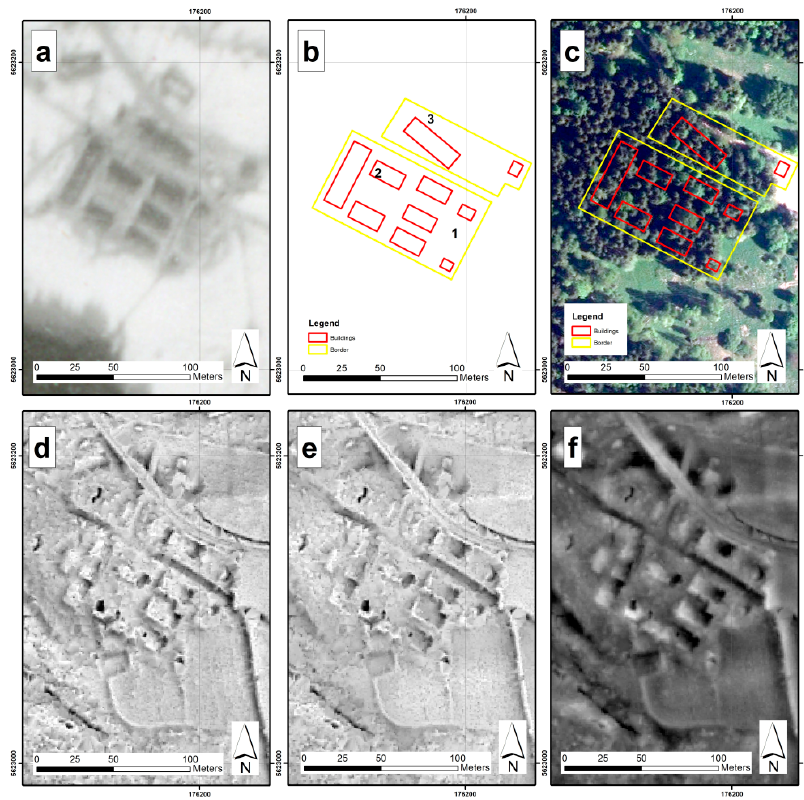
Figure 11. Labour camp AL Säuferwasser: ( a ) ’45 aerial photo (© NARA), ( b ) reconstruction of camp based on ’45 photo: 1 – presumed camp kitchen, 2 – “roll call” square, 3 – suspected HQ, (c) recent orthophoto of camp area with outlined camp plan (© Head Office of Geodesy and Cartography in Poland), ( d ) SVF image (radius 5m), ( e ) Openness positive image (radius 10m), ( f ) Local Dominance image (min./max.: 10m – 10m). Coordinate grid: UTM Zone 34 N (EPSG: 32634).